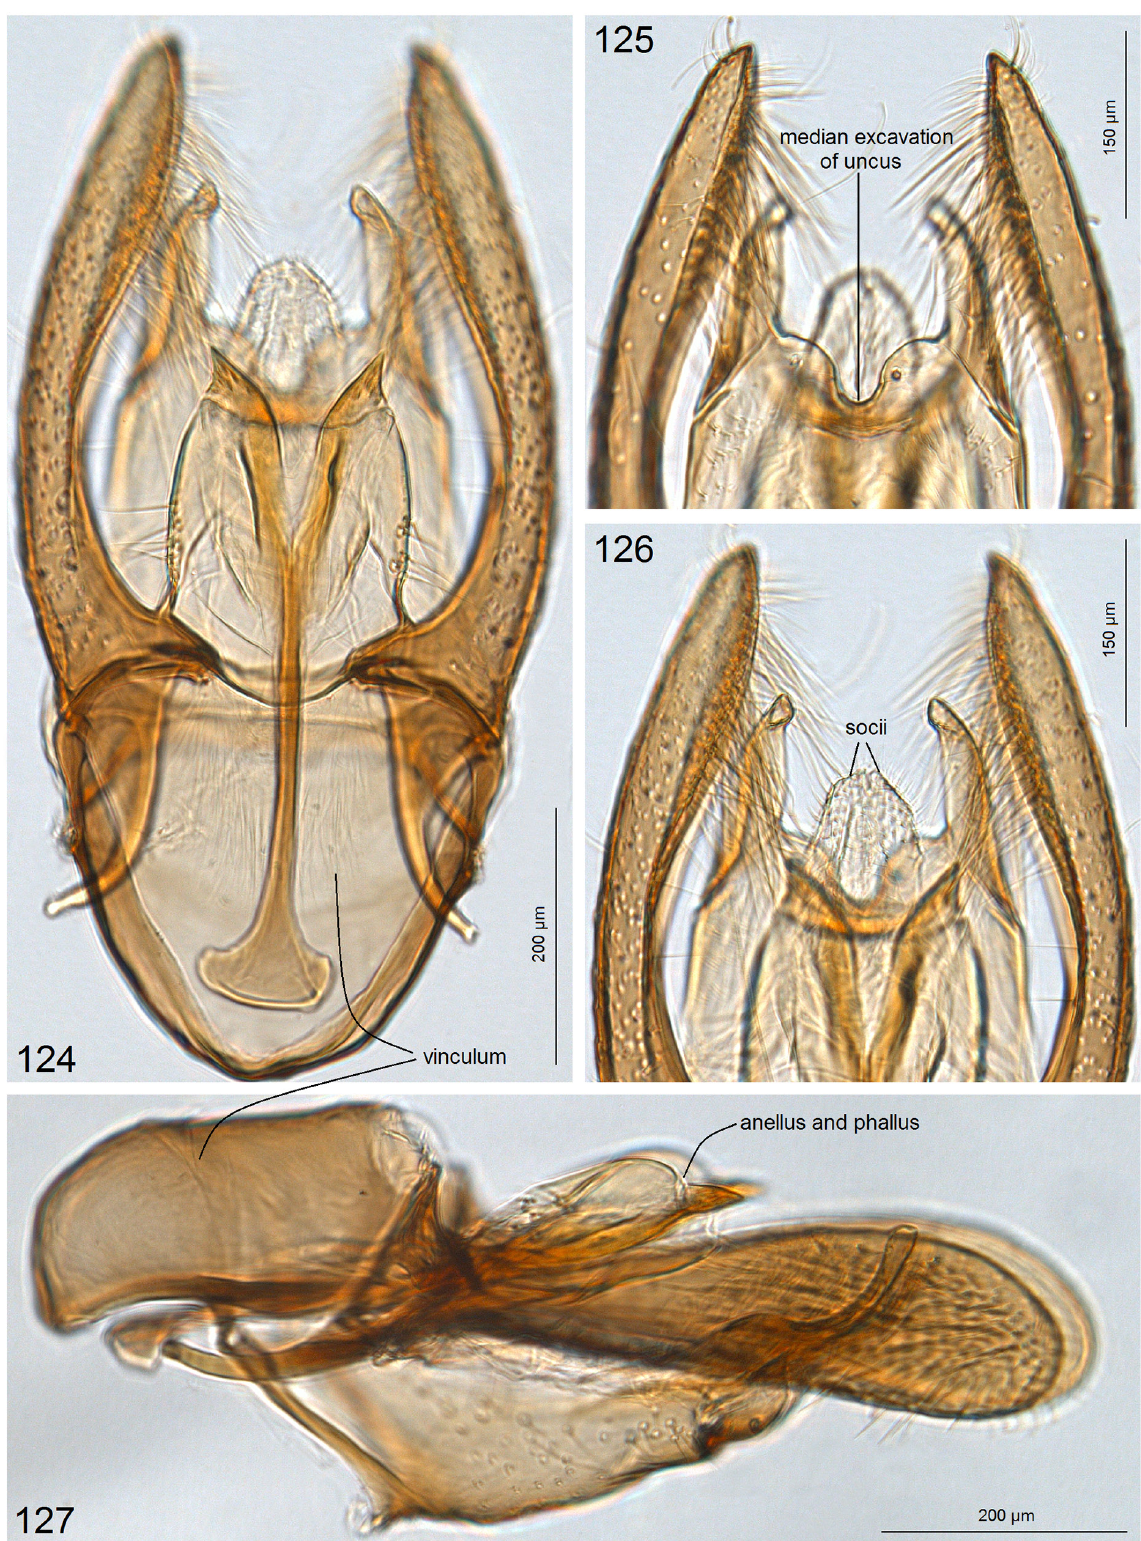
Figs 124–127. Male genitalia of Paratischeria belizensis Remeikis & Stonis sp. nov., holotype (genitalia slide no. 010316193, NHMUK). 124 . Capsule, with phallus inside. 125 . Median excavation of uncus. 126 . Socii. 127 . Lateral view of capsule with phallus